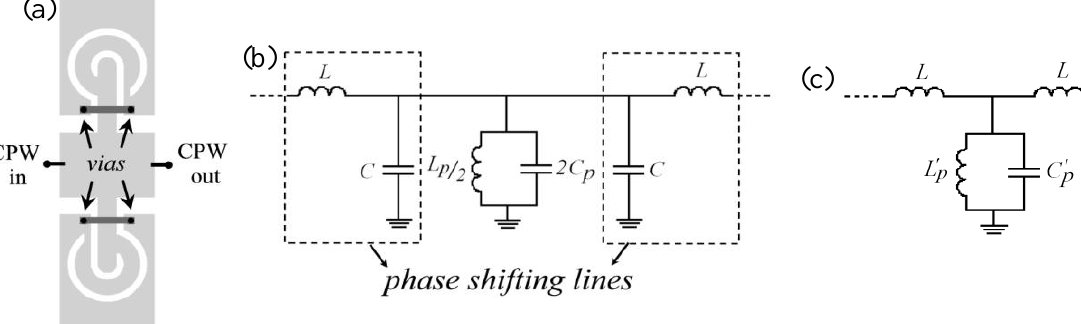
Figure 14. Layout ( a ), circuit model ( b ) and simplified circuit model ( c ) of a CPW transmission line loaded with a pair of open complementary split ring resonators, where C’ = 2 C + 2 C and L’ = L /2. The backside strips (in dark grey) connecting the different p p p p ground plane regions are necessary to prevent the slot mode of the CPW and the second resonance of the open complementary split ring